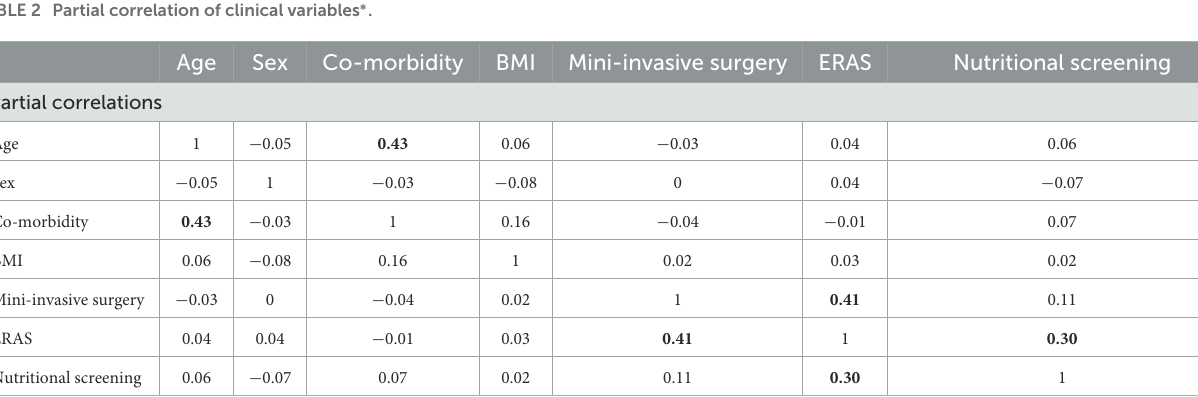
TABLE 2 Partial correlation of clinical variables ∗ .